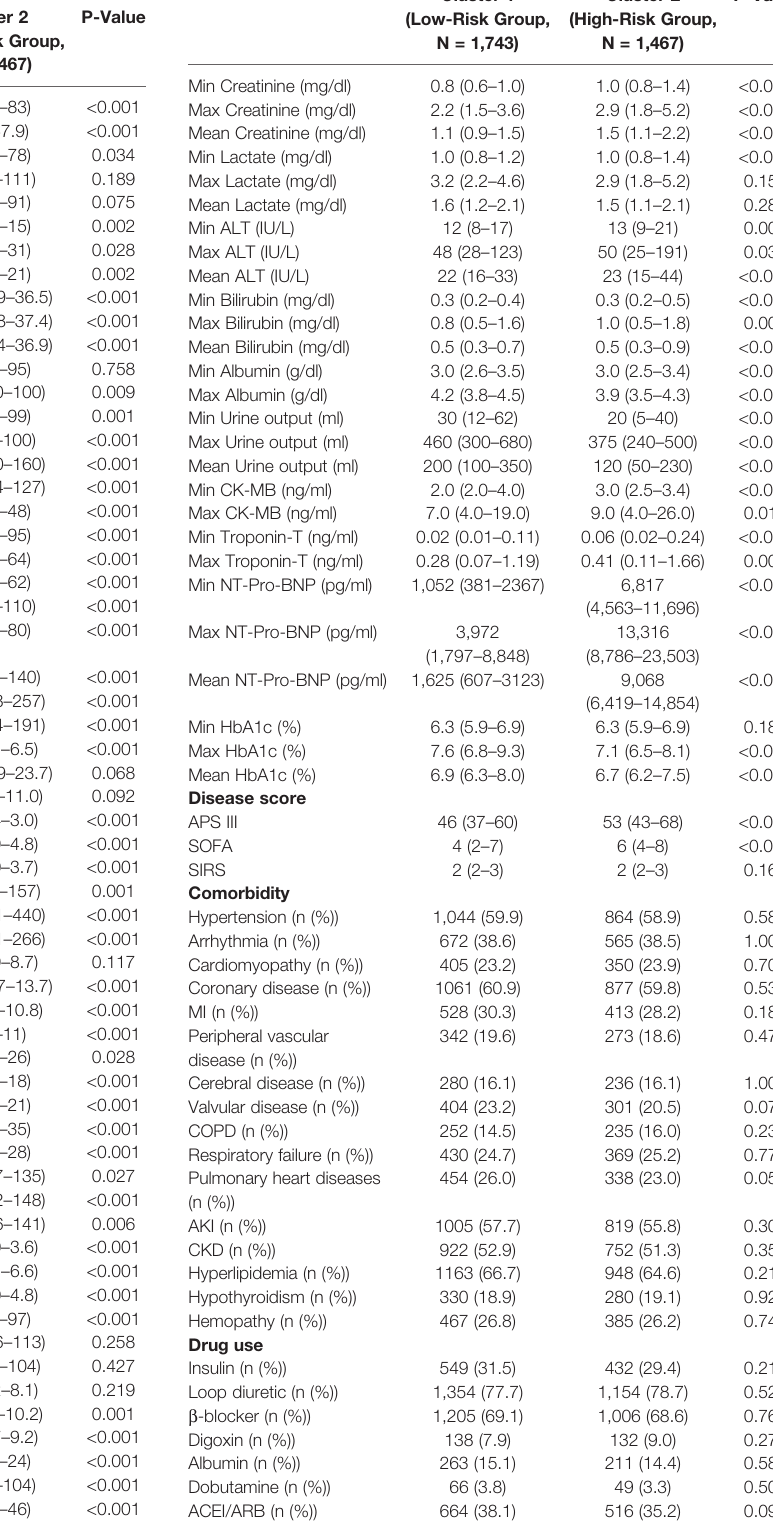
TABLE 1 | Baseline characteristics of the low-risk group and high-risk group after cluster analysis in MIMIC-IV